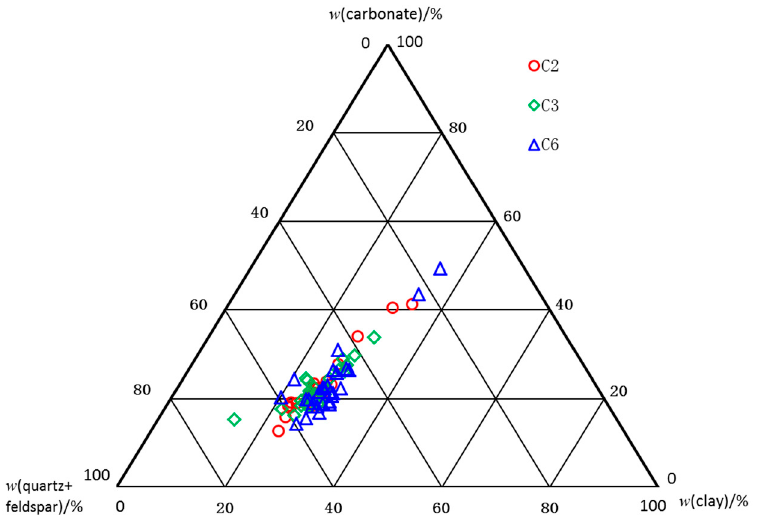
Figure 5. Ternary diagram of shale mineral at different depths in the upper part of Es3 in well F39x1.